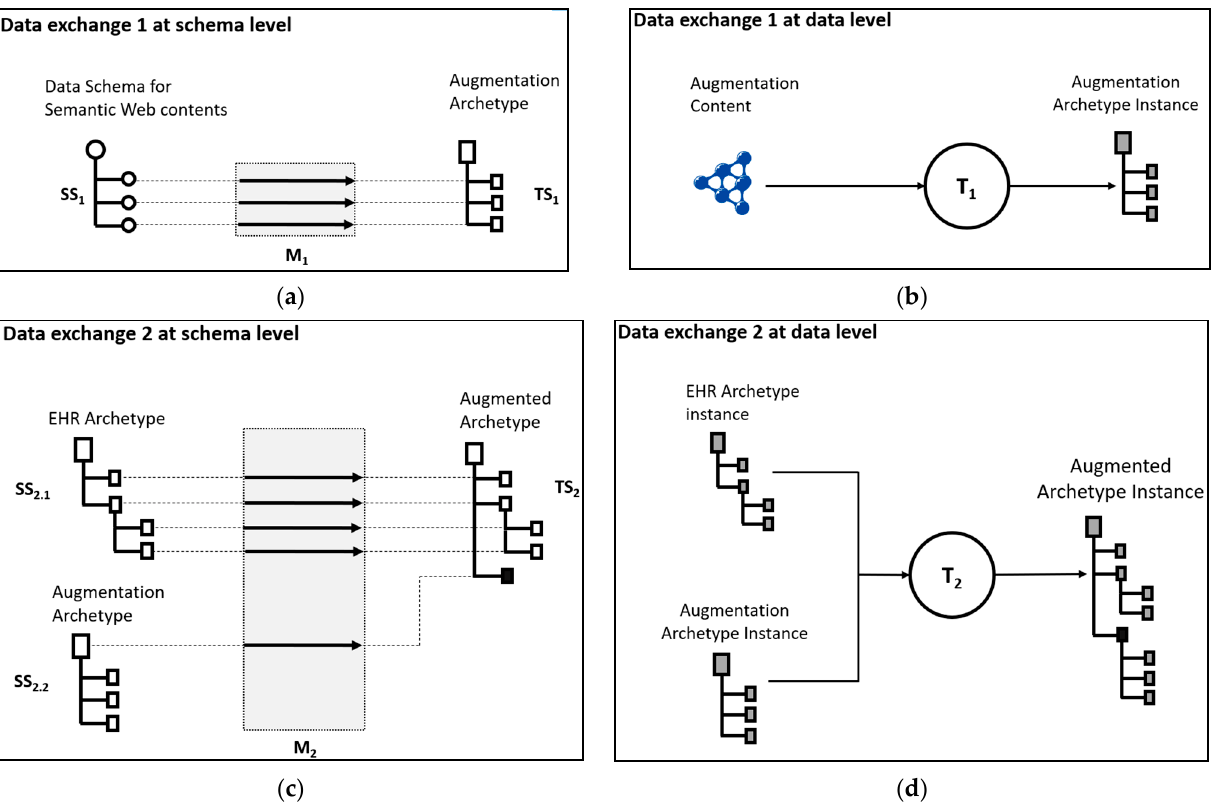
Figure 1. Data exchange operations required to build augmented EHR extracts. ( a ) At schema level and ( b ) at data level depict the operations to normalize the augmentation content as an EHR extract, whereas ( c ) at schema level and ( d ) at data level show the operations to transform the initial EHR extract plus the normalized augmentation content into an augmented EHR extract.